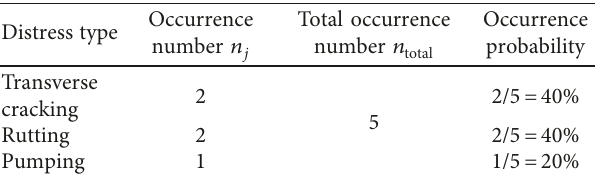
Table 5: Calculation process of occurrence probabilities for the example in Table 3.